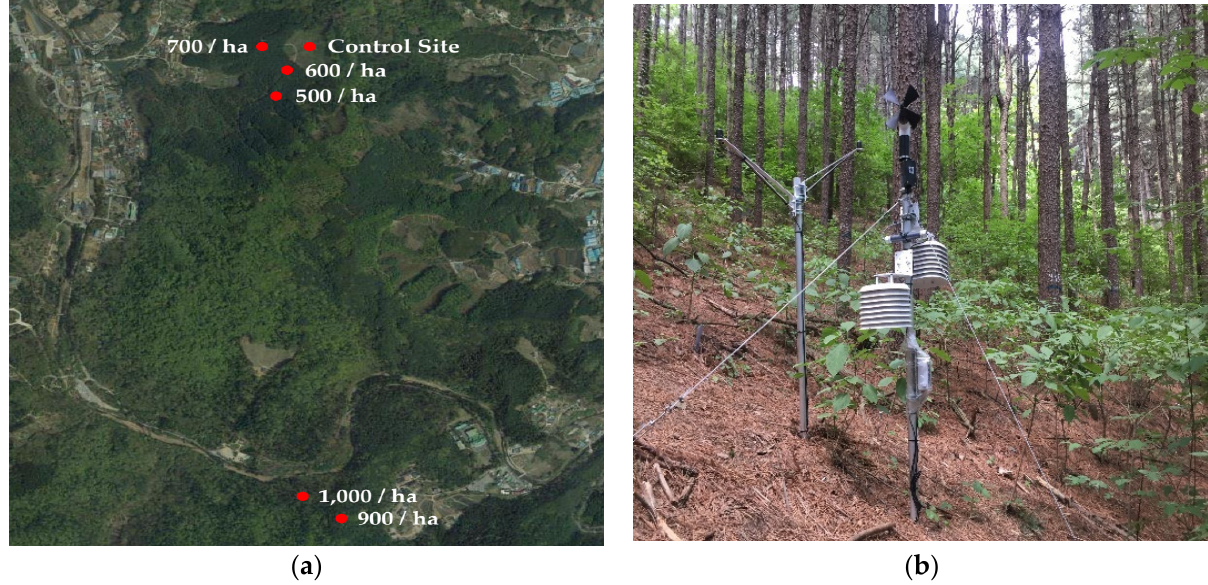
Figure 1. Images of study sites: ( a ) P. koraiensis forests of Gwangneung Experimental Forest; ( b ) field experiments on measurements of NVOCs and microclimate factors of P. koraiensis forests.